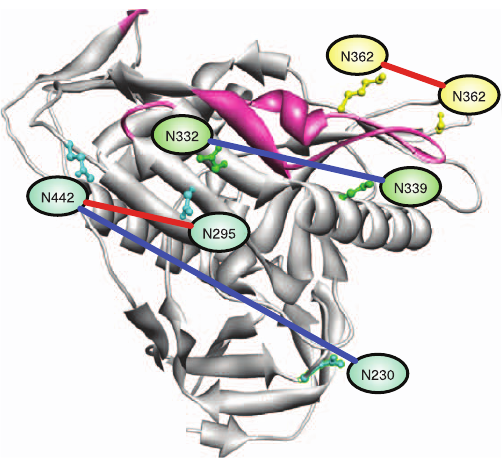
Figure 3. Interacting PNGS Mapped to Structural Model of gp120 Arcs from the consensus network are mapped to asparagine residues in the structure of a folded CD4-bound gp120 protein. The host cell- binding face of gp120 is oriented towards the top of the figure, and variable loops (of which many residues are truncated) are highlighted in pink. Arcs are colored red to indicate mutual exclusion, and blue indicates co-occurrence of the PNGSs. The asparagine residues of mutually exclusive PNGSs N295/N442 and N362/N465 are located within ; 12 A˚ of one another. In contrast, co-occurent PNGSs are separated by much greater intramolecular distances.